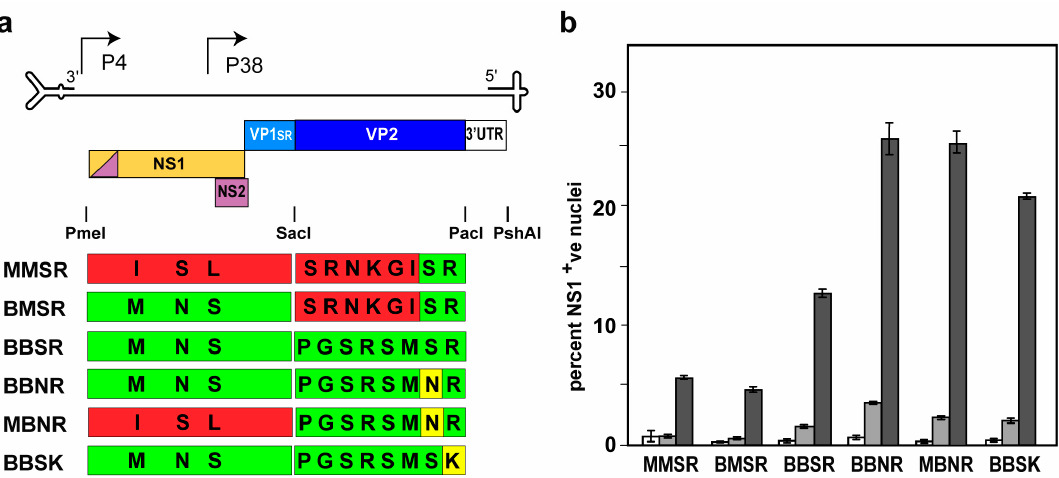
Figure 4. Construction and analysis of chimeric MPV1 and MPV1p5 viruses. In ( a ), the genetic strategy of the protoparvoviral genome is shown above as a bar diagram representing maps of the chimeric viruses created from clones described in Figures 2 and 3. Chimeras were constructed by insertion of NS/VP1 or VP2 sequences between the PmeI and SacI, or SacI and PacI sites, respectively, in the MVMp backbone. For this set of chimeras, the MVMp 3 ′ UTR was substituted with the MPV1 sequence between the PacI and PshAI sites in each construct, as described in the text. The colors in the chimera diagrams reflect those assigned to the appropriate sequence blocks in Figures 2 and 3. ( b ) B16F10 cells were infected with the indicated viruses at 10-fold increasing multiplicities (white bars = 50, light grey bars = 500, and dark grey bars = 5000 genome equivalents per cell) and analyzed for NS1 expression by flow cytometry, as described for Figure 1. Each infection was performed in duplicate, and error bars represent the standard deviation. Naming is based on the origin of each fragment, M for MPV1 and B for MP1p5. The first letter denotes the origin of the NS/VP1 fragment, the second letter denotes the VP2 fragment, and the third and fourth letters denote the amino acids present at codons 348 and 349 in VP2 .